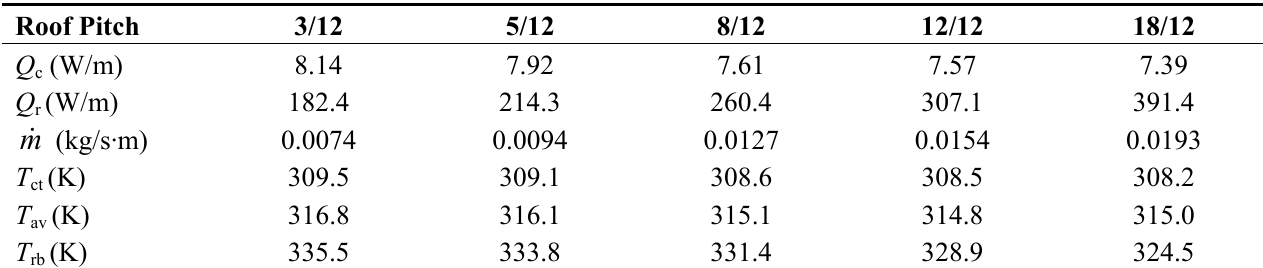
Table 2. Summary of numerical results for R-40 cases.